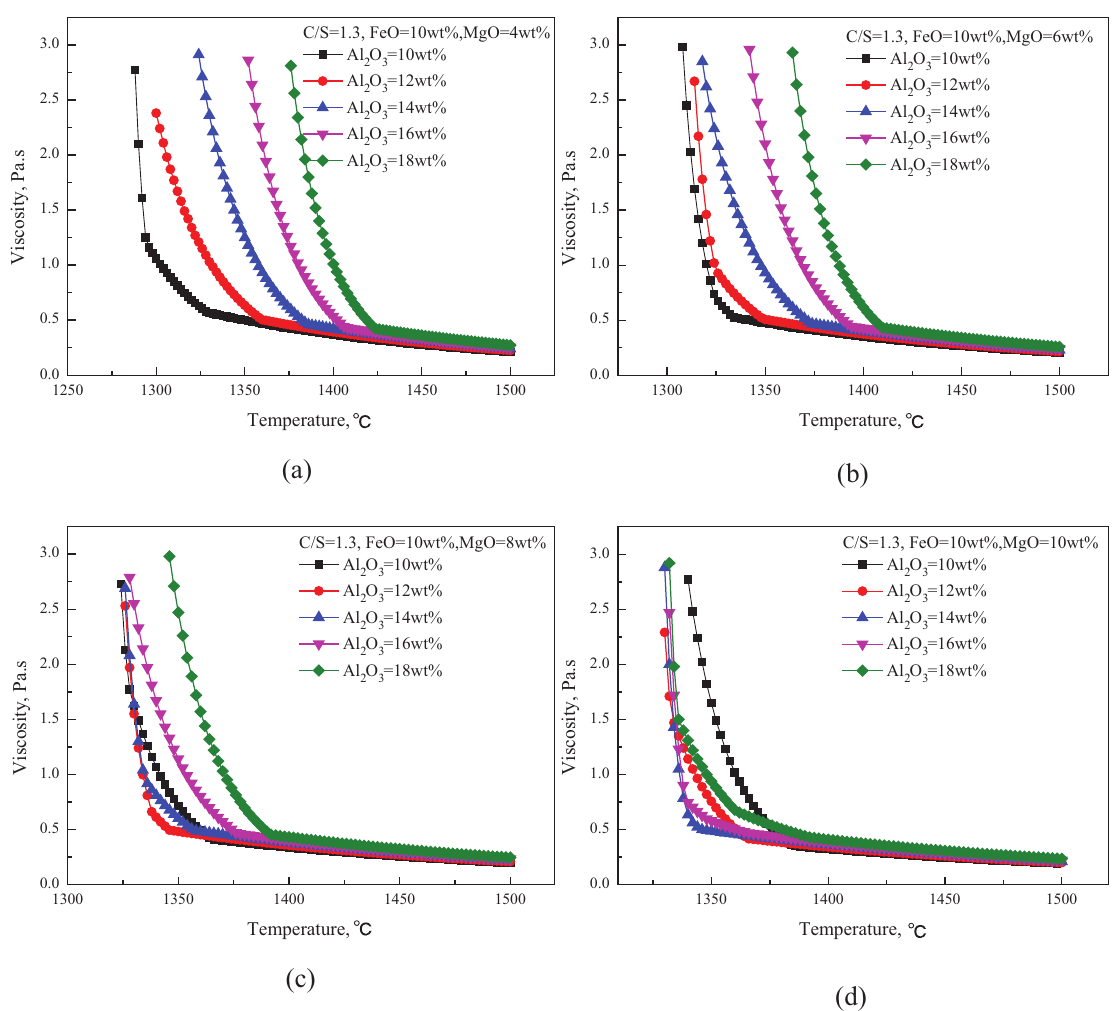
Figure 3: Viscosities of CaO – SiO 2 – Al 2 O 3 – MgO – 10 wt% FeO systems by varying Al 2 O 3 content as a function of temperature at C/S = 1.3: